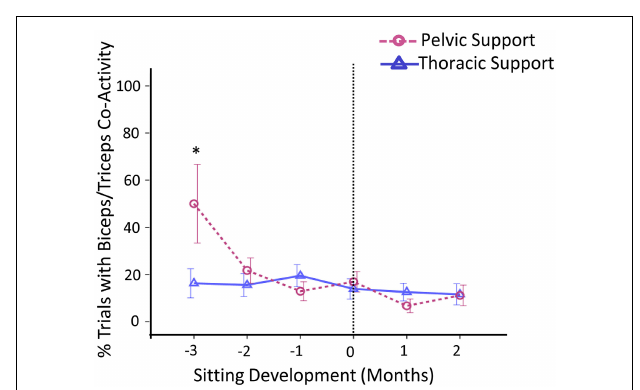
developmental time in months for thoracic (solid line with triangles) vs. pelvic (dashed line with circles) support. Vertical dotted line represents time of sitting onset. Error bars, ± 1 SE. ∗ p < 0 . 05, ∗∗ p < 0 . 01.